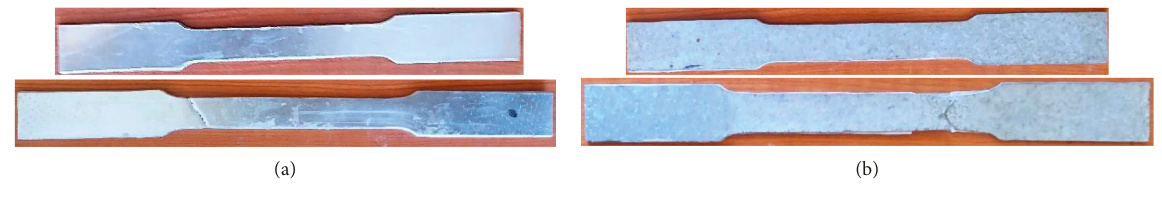
Figure 5: Tensile specimen deformation of APA (a) and GPG